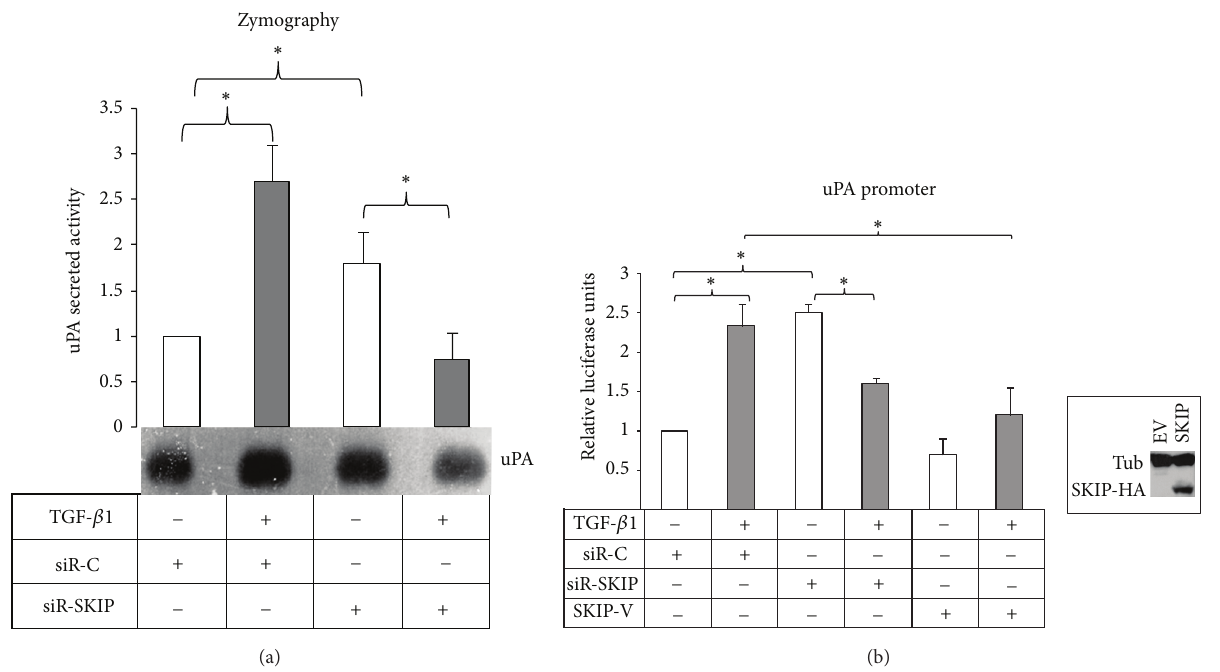
Figure 2: Effect of SKIP knockdown on TGF- 𝛽 1-induced uPA expression. (a) Secreted uPA activity determined by zymography in the serum- free conditioned media of PC-3 cells transfected either with control siRNA (siR-C) or siRNA-SKIP (siR-SKIP), and treated or not with TGF- 𝛽 1 for 24 h. (b) Transactivation of uPA promoter in PC-3 cells transiently transfected with uPA promoter construction and siR-C, siR-SKIP or SKIP-Ha tagged expressing vector (SKIP-V) and treated with TGF- 𝛽 1 for 48 h. The correct expression of ectopic SKIP-HA in PC-3 cells was tested by Western Blot (insert).